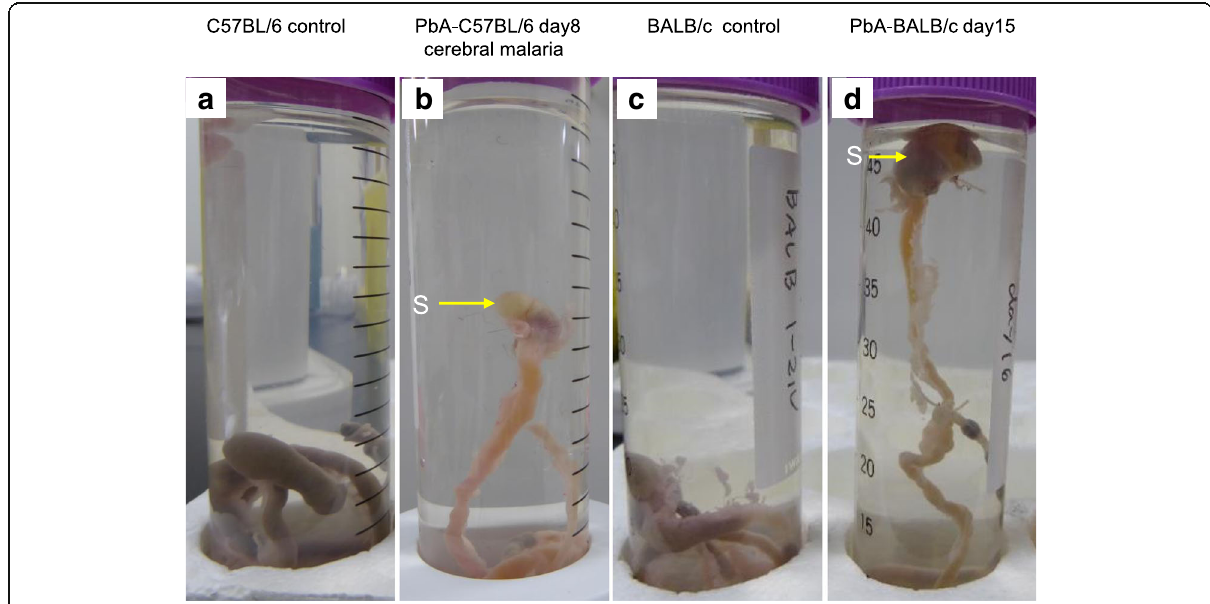
Fig. 4 The gastrointestinal tracts in saline to examine gastric gas retention. a The stomach of an uninfected C57BL/6 mouse did not float. b The stomach of a PbA-C57BL/6 mouse with cerebral malaria floated to the middle of the tube. c The stomach of an uninfected BALB/c mouse did not float. d The stomach of a PbA-BALB/c mouse on day 15 floated to the surface. S,